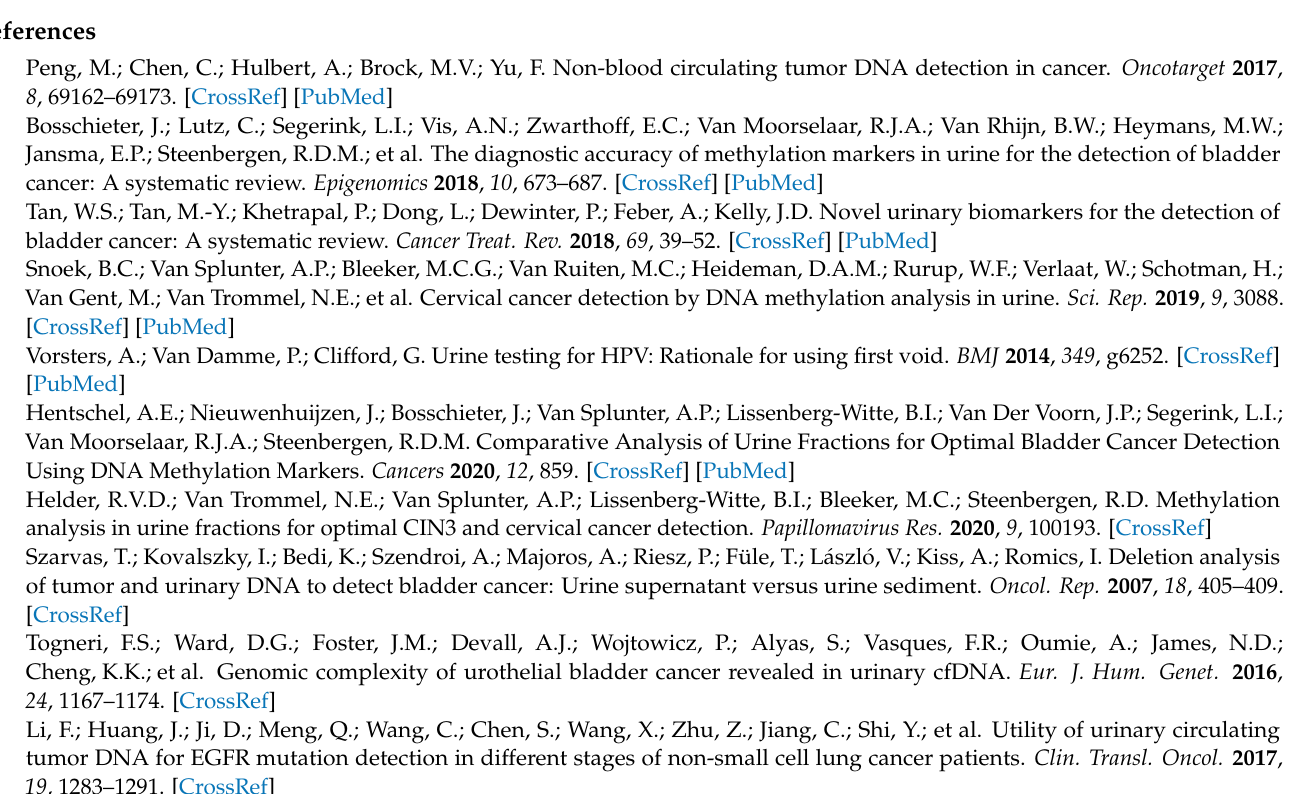
Table S3: Overview of the average number of reads per sample